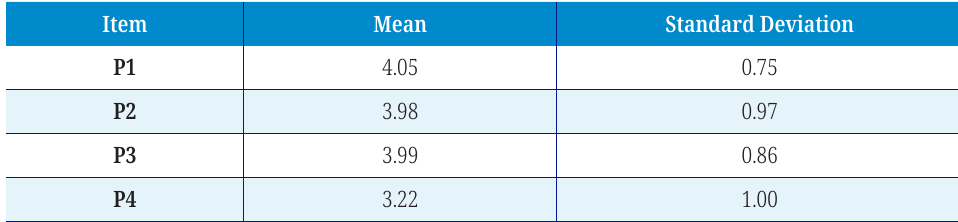
Table 4. Mean obtained by dimension 1 items